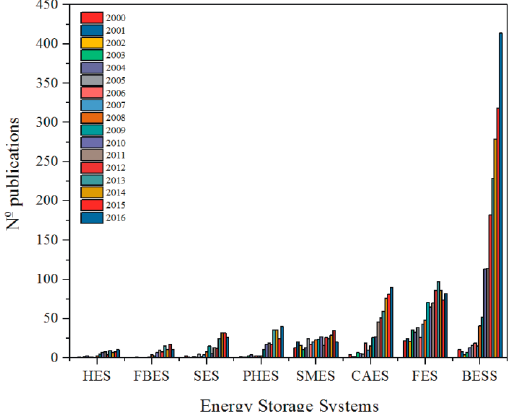
Figure 1. Energy storage systems (ESS). HES: hydrogen-based energy storage system; FBES: flow battery energy storage; SES: supercapacitor energy storage; PHES: pumped hydro energy storage; SMES: superconducting magnetic energy storage system; CAES: compressed air energy storage; FES: flywheel energy storage and BESS: battery energy storage systems.